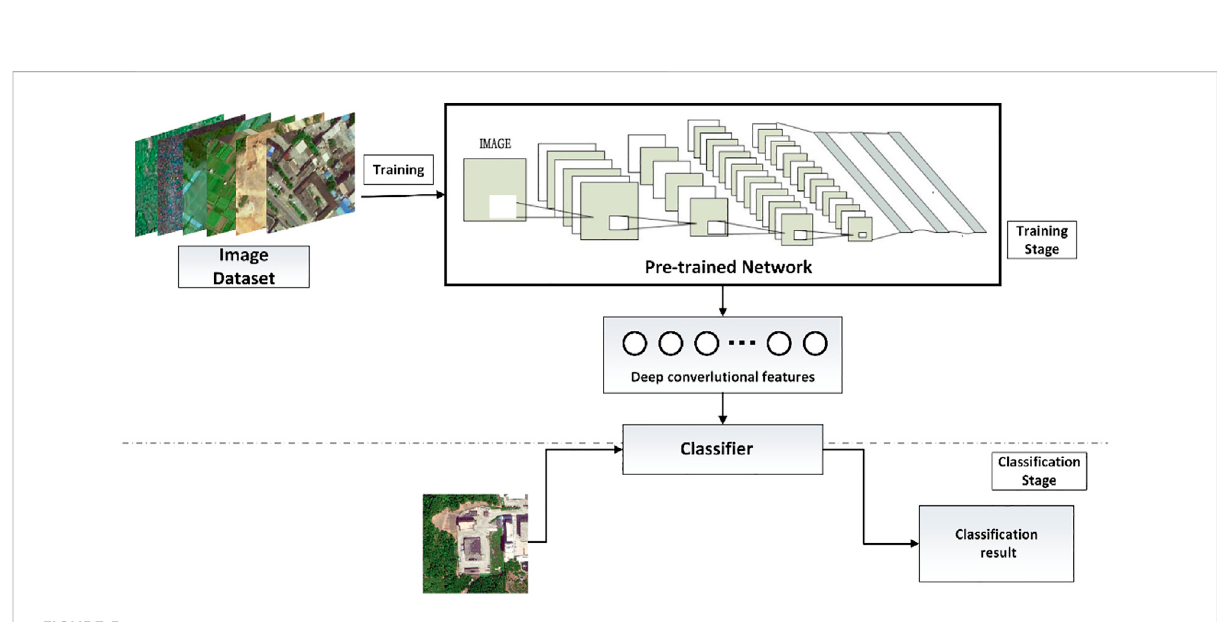
FIGURE 5 Work fl ow diagram of the fi ne-tuned